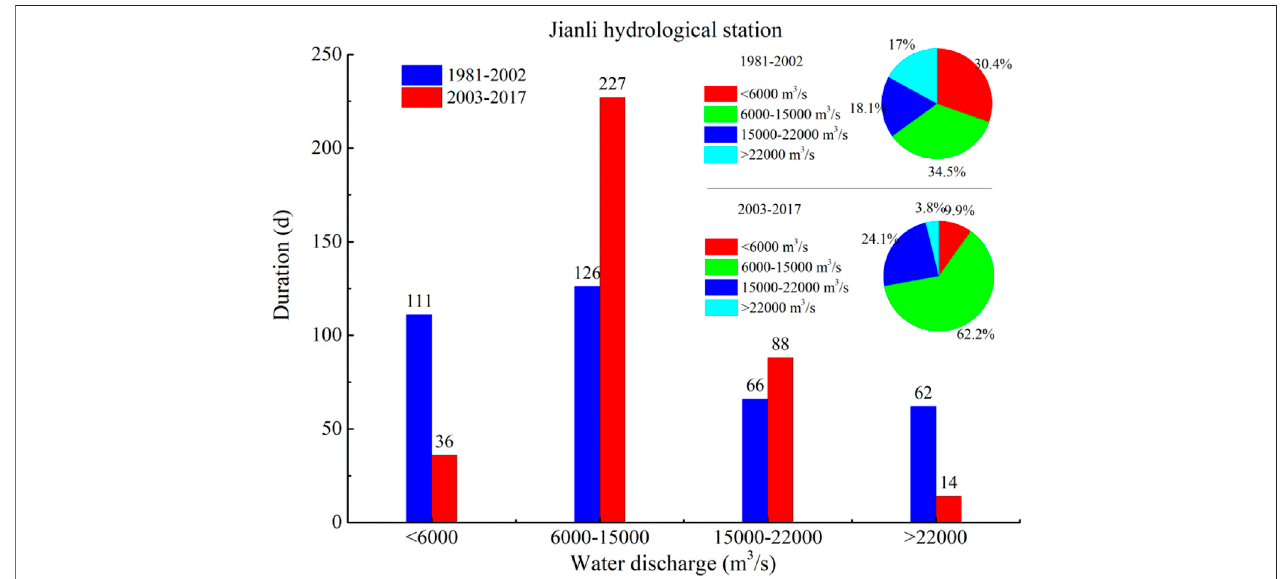
FIGURE 3 | Duration of characteristic discharges at the Jianli hydrological station before and after the TGP operation.